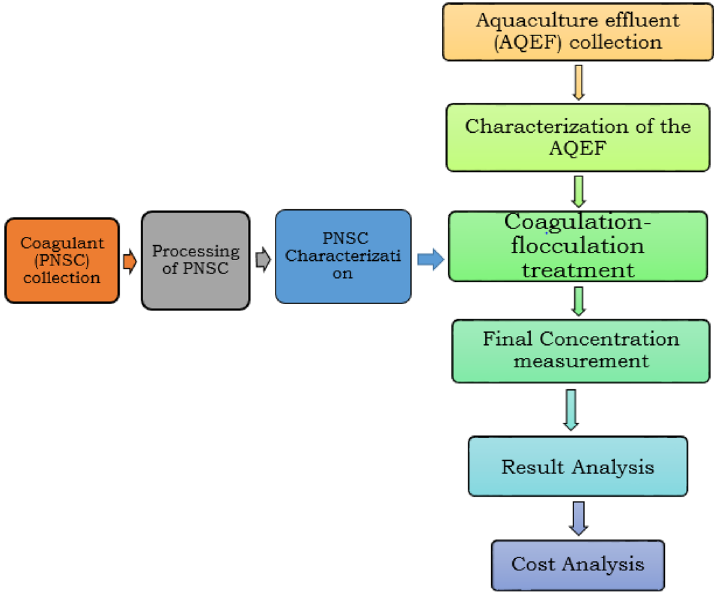
Figure 1. The schematic flow of the current research, from identification/collection of aquaculture effluent and Picralima nitida seeds, Jar test experiment, and final concentration measurement, before the result and cost analyses.